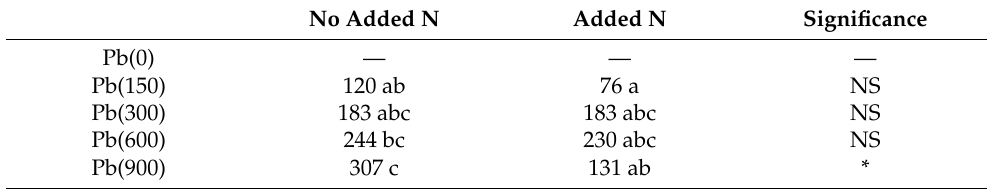
Table 4. Number of harvests of purslane necessary to halve the initial Pb soil concentration. No Added N Added N Pb(0) — — — Pb(150) 120 ab 76 a NS Pb(300) 183 abc 183 abc NS Pb(600) 244 bc 230 abc NS Pb(900) 307 c 131 ab *